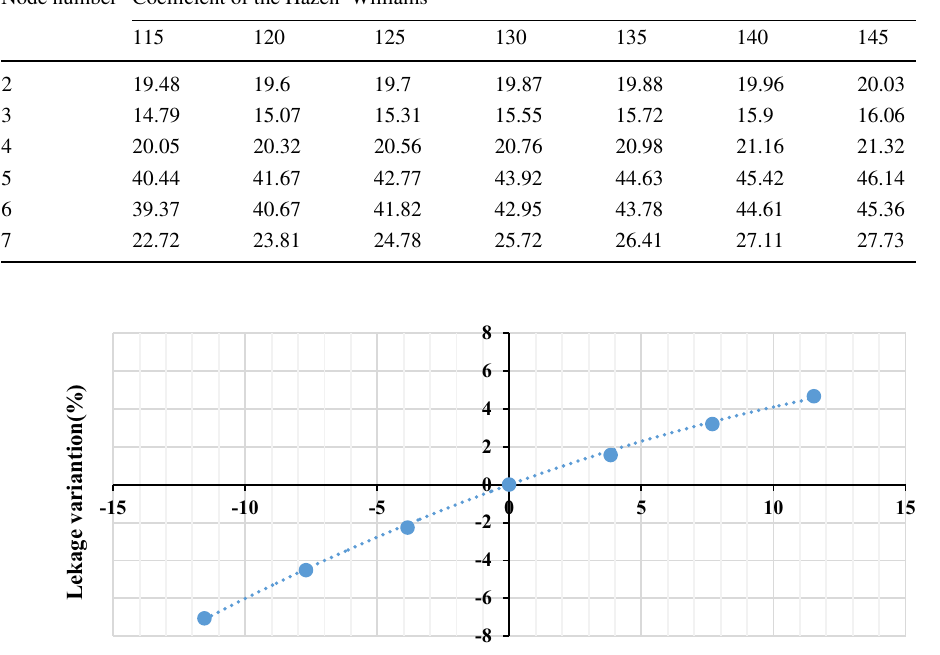
Hazen-Williams coefficint